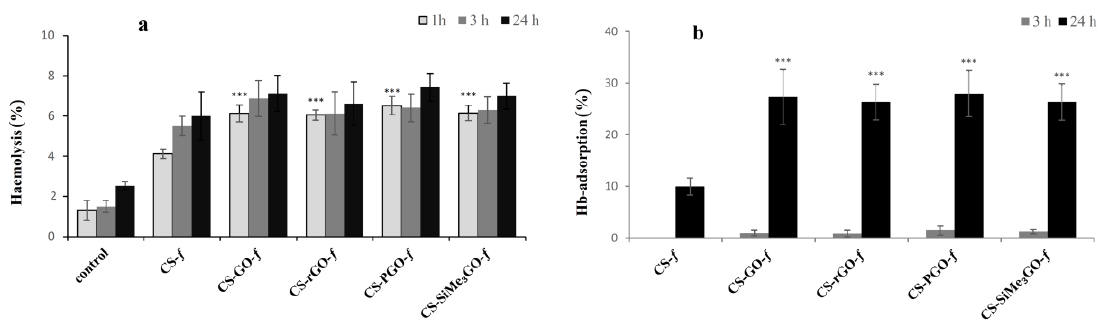
Figure 7. Hemolysis ( a ) and hemoglobin adsorption ( b ) of chitosan-reinforced graphene films.